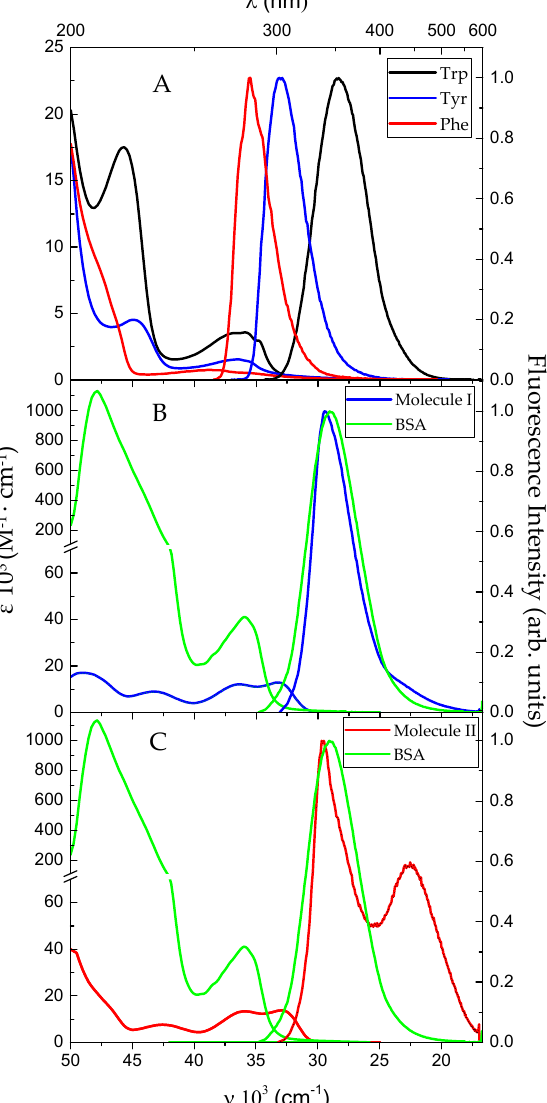
Figure 1. Absorption and emission spectra of the three crucial aromatic amino acids ( A ), BSA ( B , C ) and investigated dyes ( B , C ) in phosphate buffer solution (pH 7.4). In order to better visualize the absorbance scale (representing the molar absorption coefficient) for BSA and investigated molecules, the ordinate axis has been truncated.